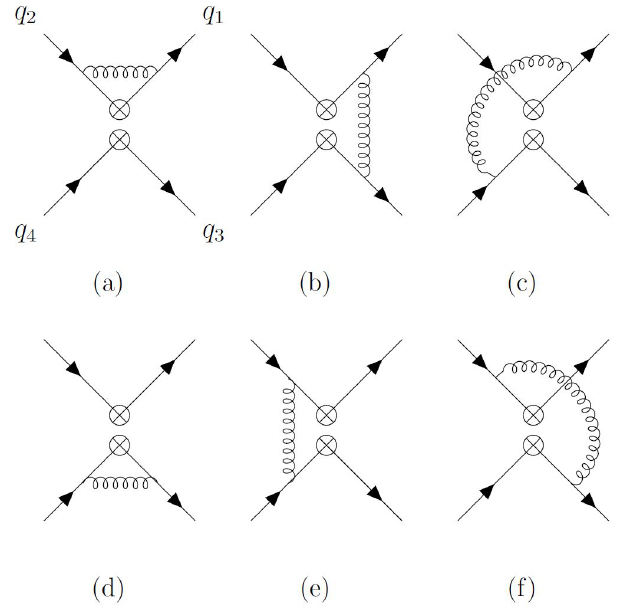
Figure 1. One-loop QCD vertex corrections to four-quark